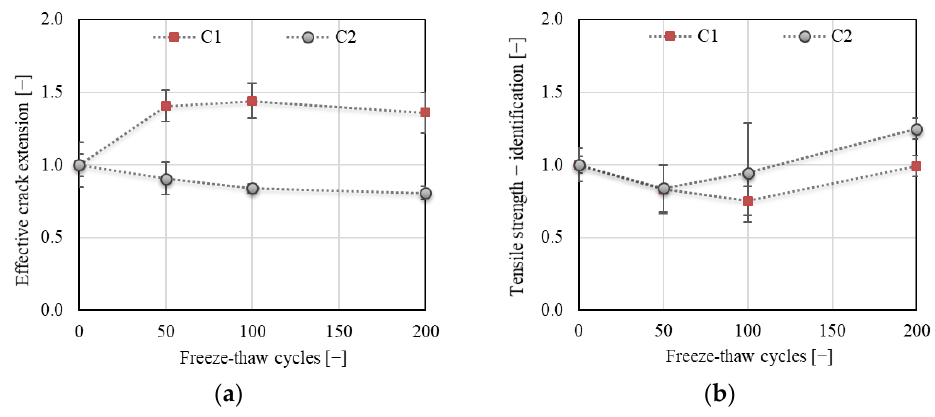
Figure 14. ( a ) Effective crack extension; ( b ) tensile strength from identification.